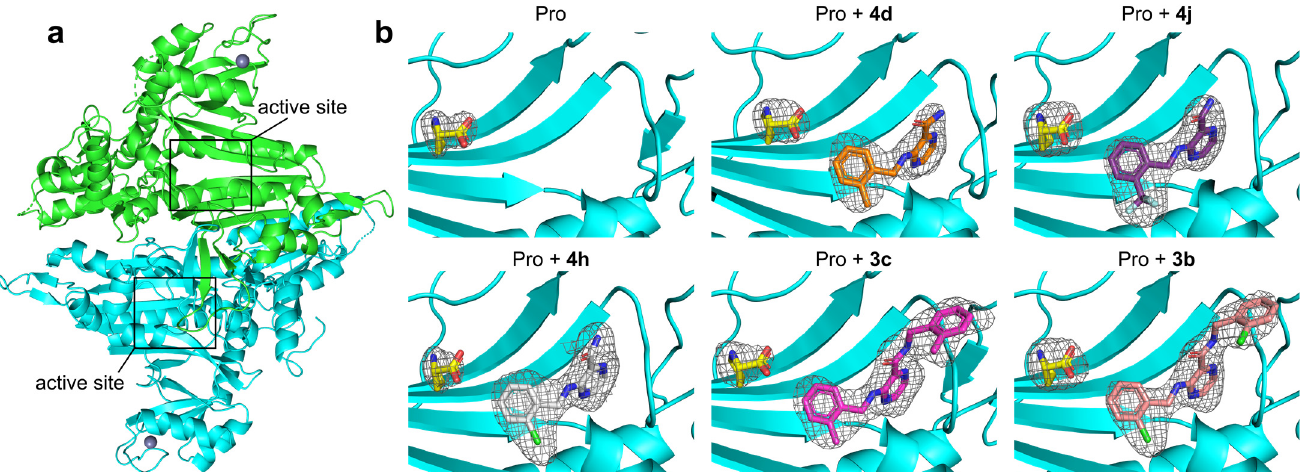
Figure 4. Crystal structures of HcProRS complexes. ( a ) Overview of HcProRS structure in the asymmetric unit. The overall structure is shown as a cartoon representation with chain A and chain B coloured in green and cyan, respectively, while Zn 2+ ions are shown as grey spheres. ( b ) Omit maps of ligands in the aminoacylation site of chain B of HcProRS. From left to right, the structures are shown in the order of decreasing EC 50 values. The maps, contoured at 3 σ , were calculated in phenix.polder [24] and shown as grey mesh representations. Pro, compound 4d , 4j , 4h , 3c and 3b are shown as sticks and coloured in yellow, orange, purple, white, magenta and salmon, respectively.